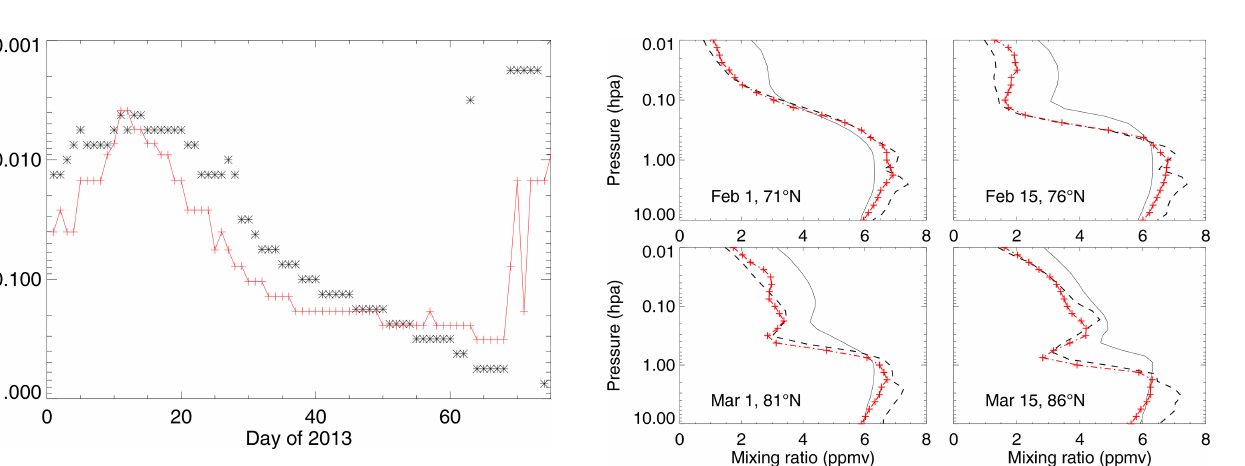
Figure 3. Zonally averaged H 2 O profiles from (solid black) WAC- CMX calculations, (dashed black) NAVGEM-HA analysis, and (red) SOFIE observations. Both WACCMX and NAVGEM-HA are sampled at the SOFIE occultation